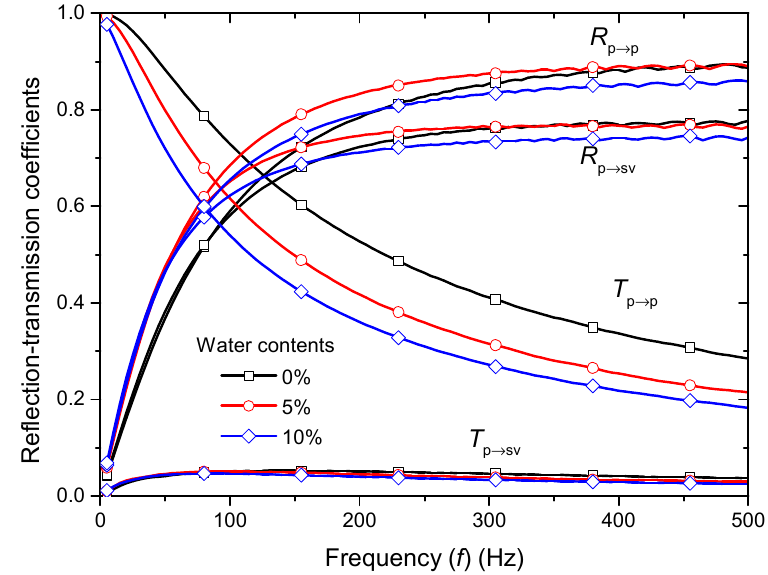
Figure 6. Variation of reflection–transmission coefficients versus the wave frequency f when a P wave impinges a filled joint with a thickness of 20 mm. The incident wave has the incident angle of 20° and the frequency of 50 Hz.